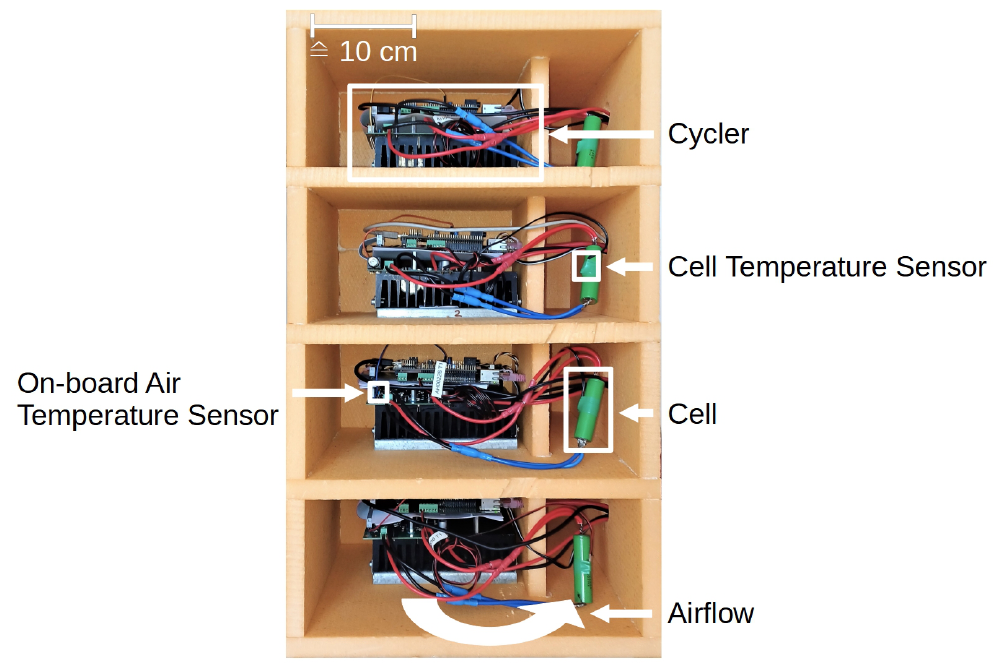
Figure 1. The four cyclers and cells under test are exposed to a circulating air stream, which is temperature controlled. A temperature sensor is attached to each cell.